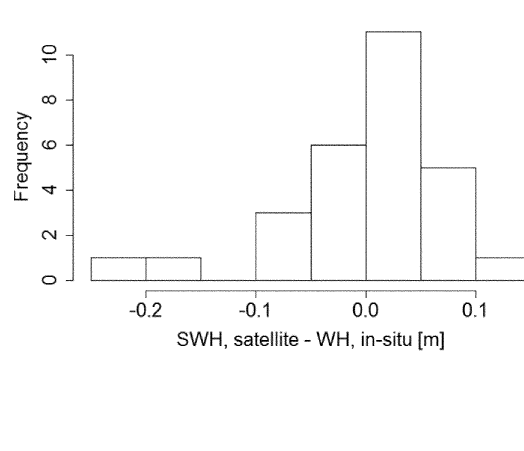
Fig. 6. Histogram of differences between in situ wave heights (WH) and adjusted JASON-1 significant wave heights (SWH) * ,sat S in situ H H  for the Derbent, Izberg and Makhachkala observation sites. The typical RMSD is 0.06